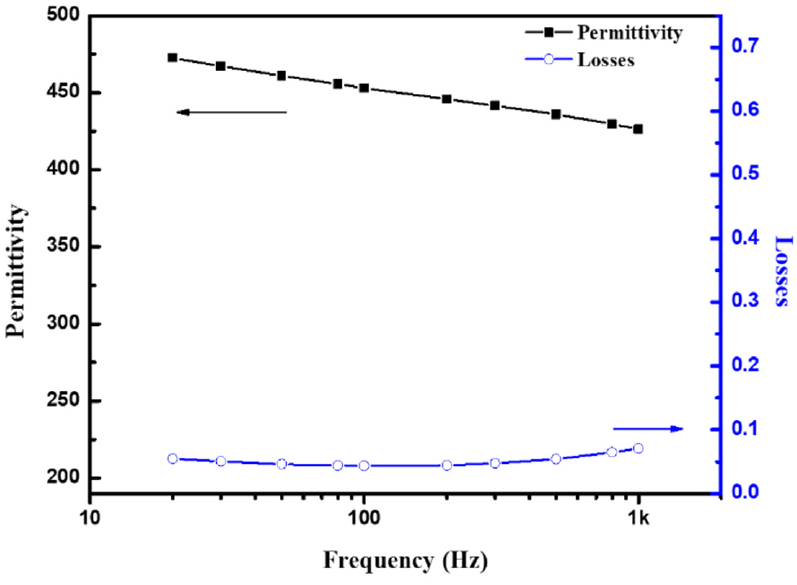
Figure 8. Frequency dispersion of permittivity and loss tangent of the 600 °C annealed PMN–PT film.